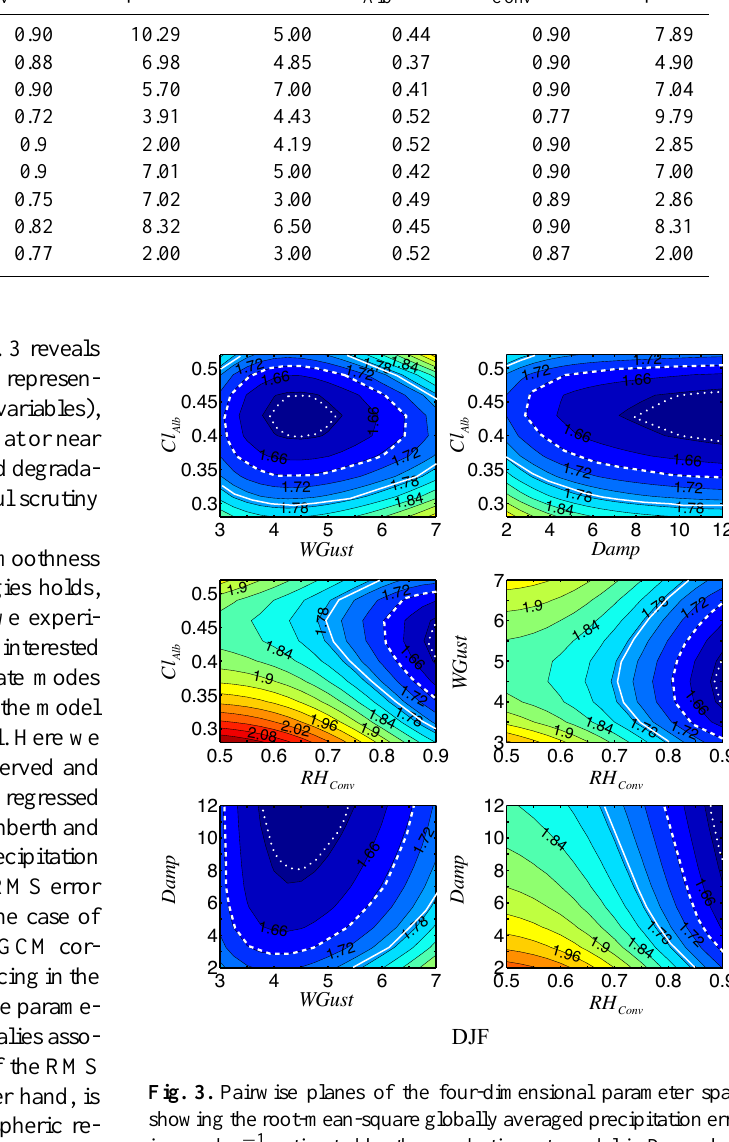
Table 1. Optimized parameter setting for nine commonly analyzed climate variables in boreal winter, December–January, and summer, June–August. WGust DJF Cl Alb DJF RH Conv DJF Damp DJF WGust JJA Cl Alb JJA RH Conv JJA Damp JJA Precip